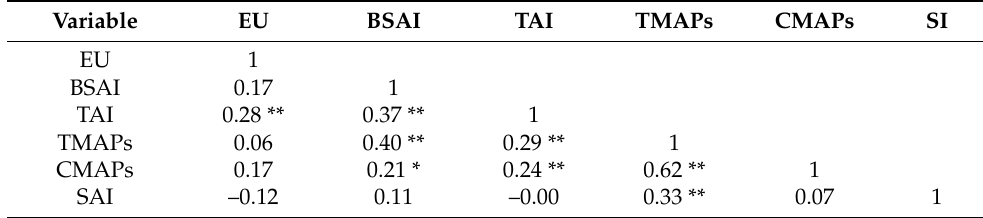
Table 3. Spearman